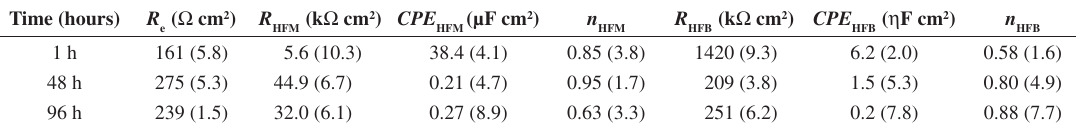
Table 6. Electrical elements fitted values for F1P60D film up to 96 h of immersion in 0.05 M NaCl solution. The error % associated with each parameter value is given in parenthesis.